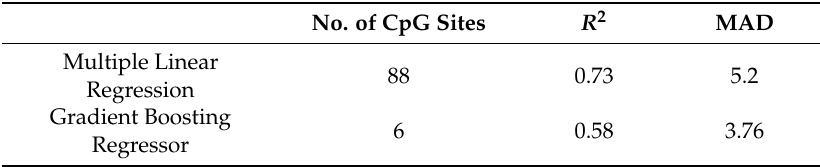
Table 7. Results of GBR and Multiple Linear Regression on saliva samples.